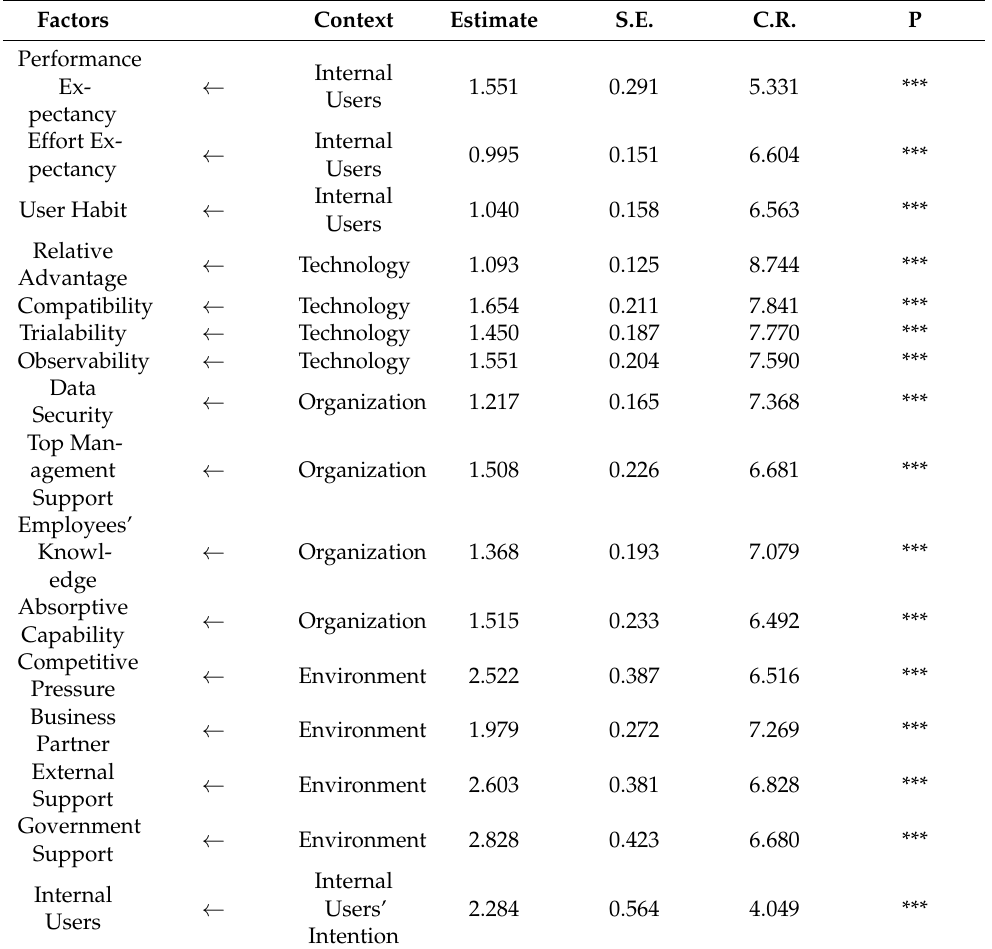
Table 6. Results of regression